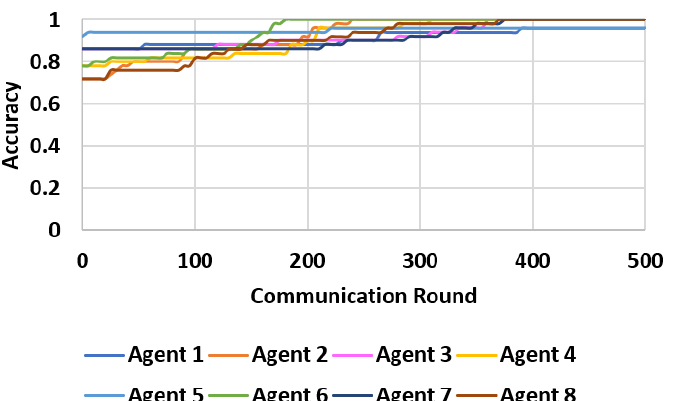
Figure 25. FedResilience’s impact on participating FL agents’ (eight agents and six stragglers) model loss for the prediction of CIAs’ resource-sharing capability.